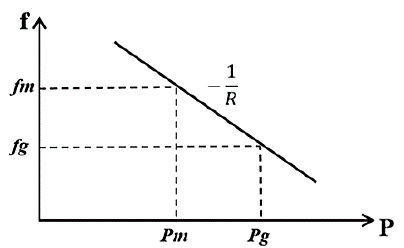
Figure 7. The droop Characteristics of the frequency.